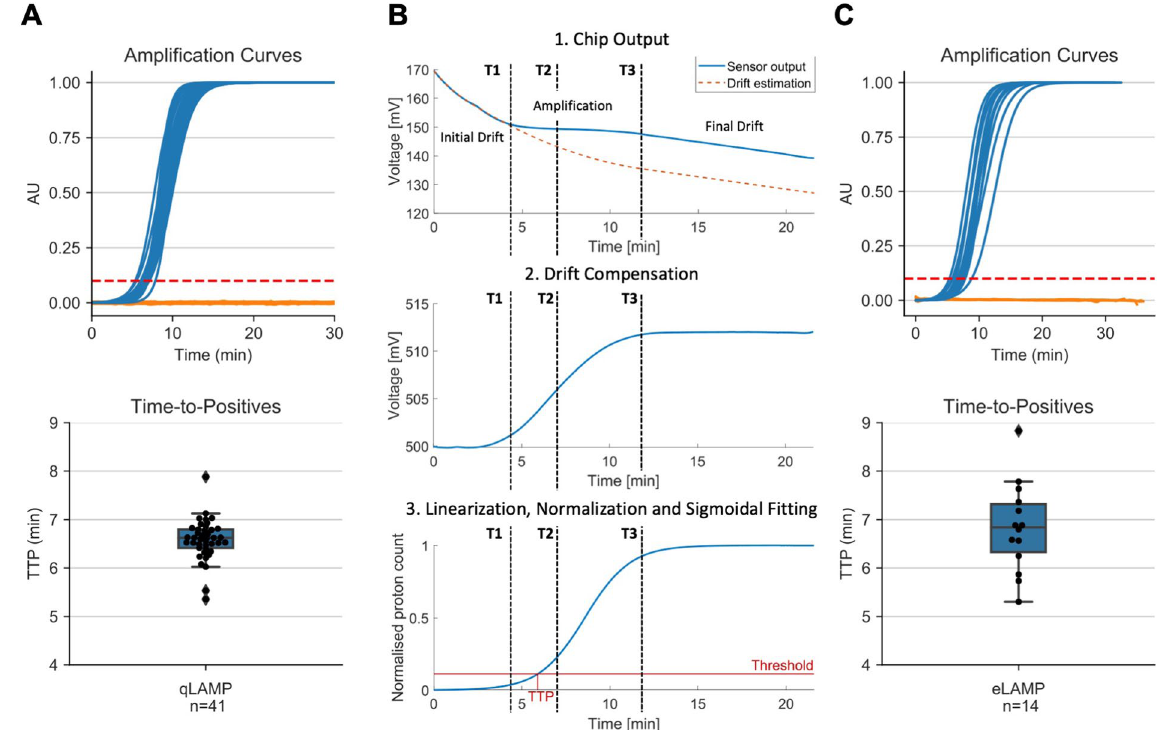
Figure 3. Performance of mcr − 9 LAMP assay using qLAMP and eLAMP. ( A ) Output from qLAMP. Top panel shows the normalized negative (n = 87) and positive (n = 41) amplification curves in orange and blue, respectively. Bottom panel shows the distribution of qLAMP TTP for positive isolates. ( B ) Algorithm to extract amplification curve and TTP from LoC ISFET array output. ( C ) Output from eLAMP. Top panel shows the normalized negative (n = 6) and positive (n = 14) amplification curves in orange and blue, respectively. Bottom panel shows the distribution of eLAMP TTP for positive isolates. TTP was extracted using a threshold at 10% of the maximum. See Figures S1–S4 and Table S4 for detailed